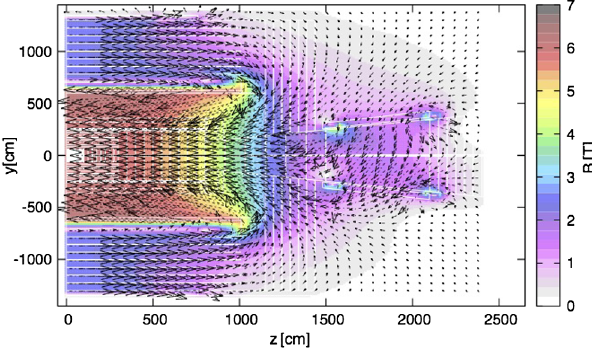
FIG. 2. Magnetic field map: lateral view for x ¼ 0 [16].